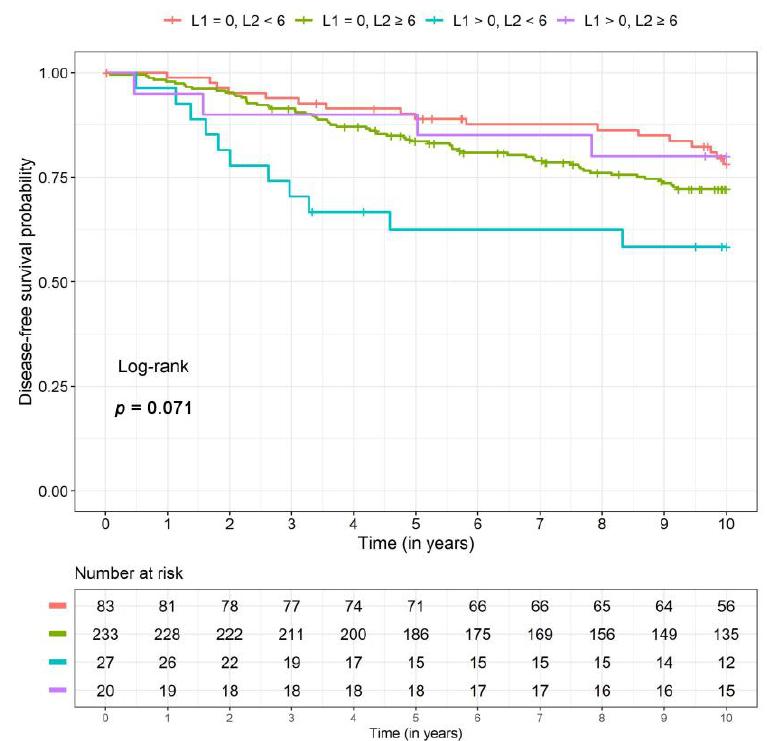
Figure 4. Kaplan–Meier curves for the four different combinations of PIWI-like 1 IRS (L1) and PIWI- like 2 IRS (L2) for overall survival.